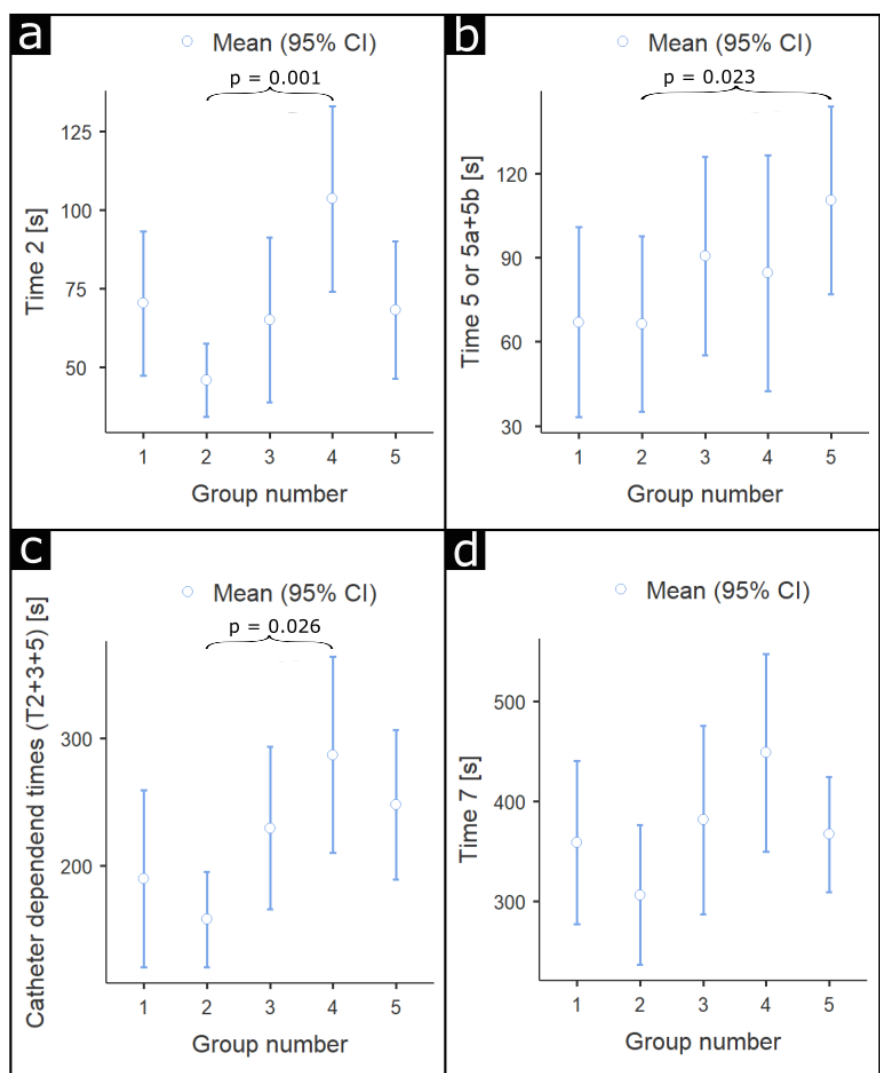
Figure 3. Differences in timeframes among groups. ( a ) T2 [s]: time needed to introduce the diagnostic catheter, from entering the vascular sheath to reaching the ascending aorta; ( b ) T5 [s]: time needed to properly engage the ostium of the other coronary artery by the catheter positioned in the ascending aorta. In the standard group, the time for T5 was separated into T5a (changing Judkins catheters) and T5b (time needed to properly en-gage the ostium of the other coronary artery);